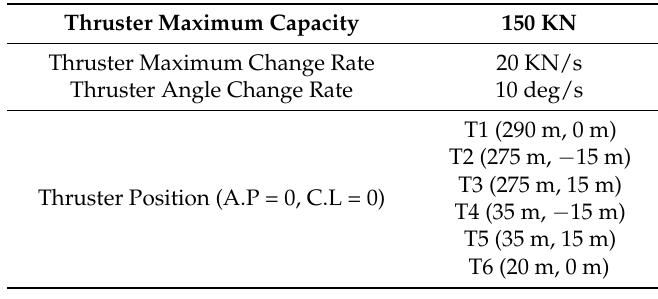
Table 7. Thruster Information.